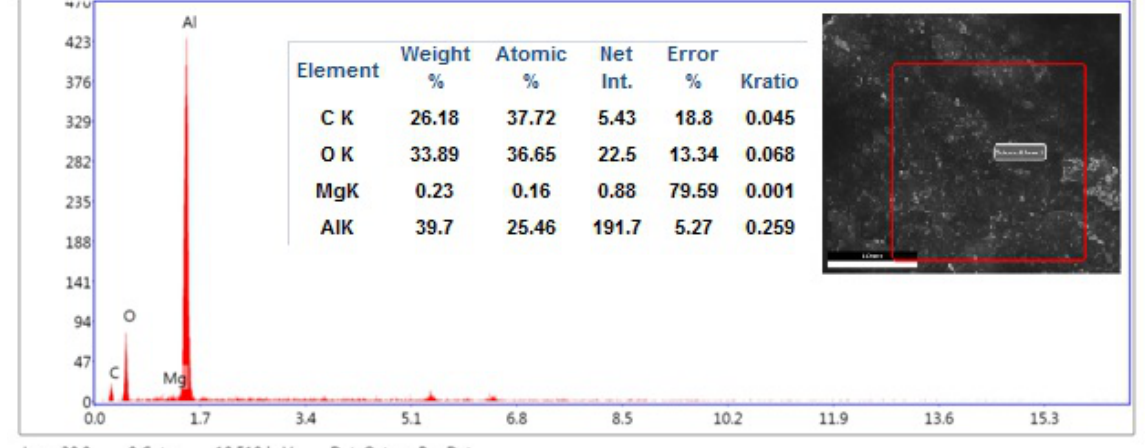
Figure 2: SEM comparison of AMCs